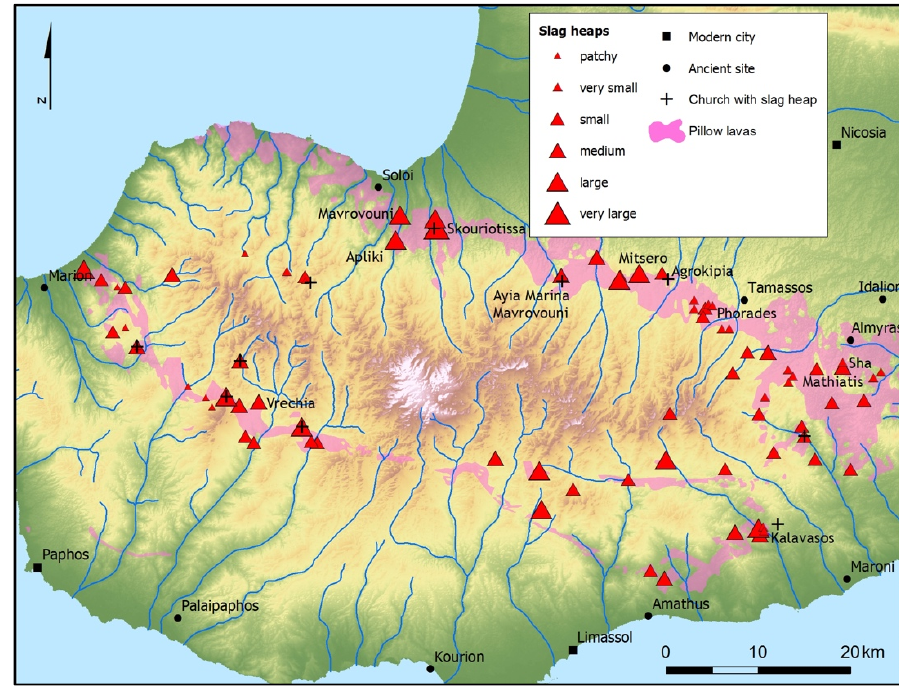
Figure 6. Map of the Troodos range with slag heaps and churches marked (Given 2018, p.